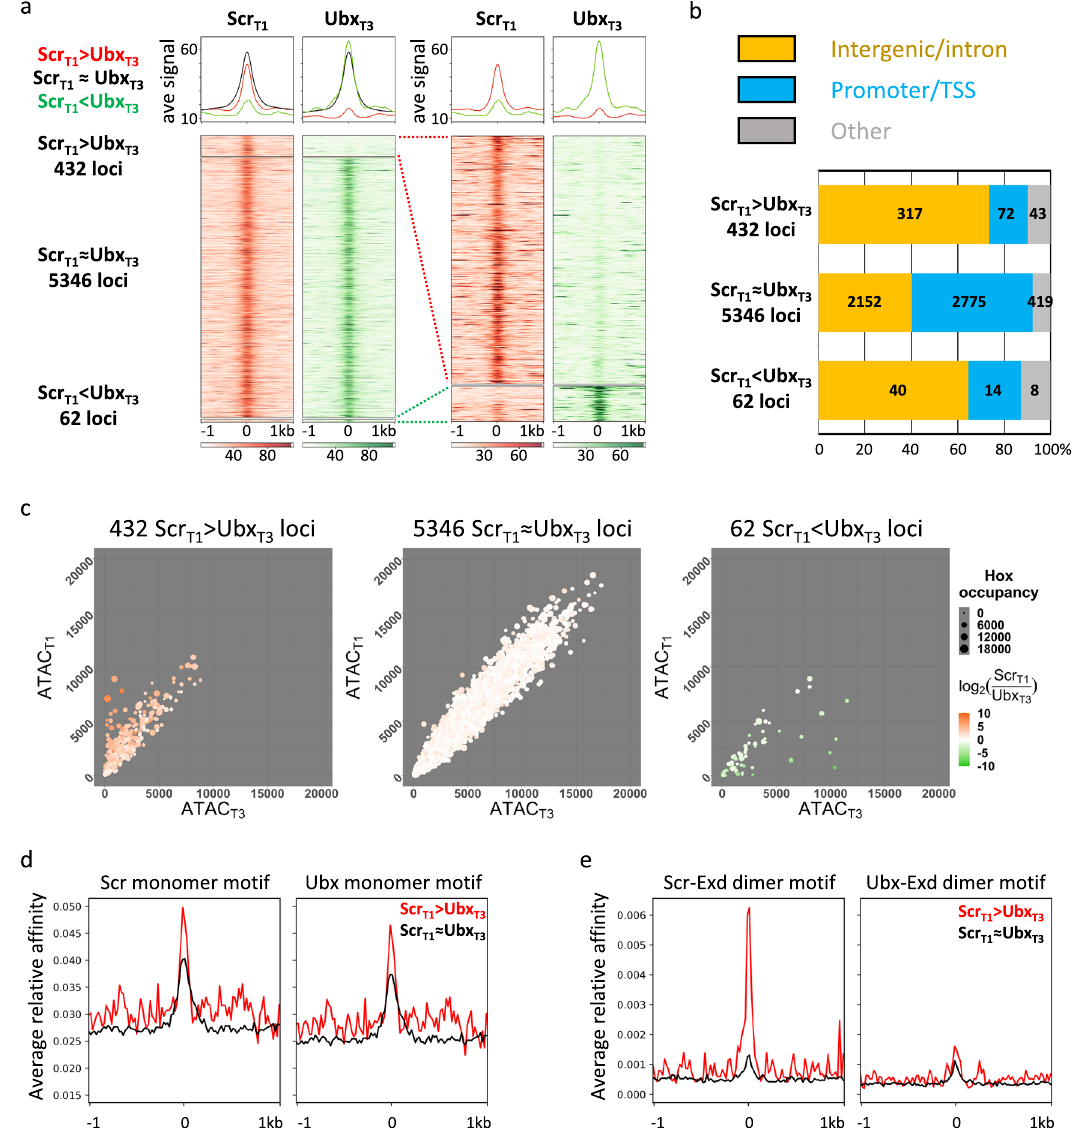
Fig. 2 Genome-wide comparison between Scr T1 and Ubx T3 DNA-binding pro fi les. a Left: heatmaps and histograms of Scr T1 > Ubx T3 , Scr T1 ≈ Ubx T3 and Scr T1 < Ubx T3 loci plotted for Scr T1 and Ubx T3 ChIPs signals. Right: blow-up of the 432 Scr T1 > Ubx T3 and 62 Scr T1 < Ubx T3 loci. Loci in each of the three classes are sorted by the FDR values generated by DiffBind in ascending order (see “ Methods ” for details). The loci are aligned at the peak center, with + / − 1 kb shown. In all heatmaps in this and other panels, the color intensity scores are arbitrary values indicating relative TF occupancy at the target locus. b Bar graph showing the genome region classi fi cation of Scr T1 > Ubx T3 , Scr T1 ≈ Ubx T3 and Scr T1 < Ubx T3 loci. c Scatter plots comparing T1 and T3 chromatin accessibility in Scr T1 > Ubx T3 (left), Scr T1 ≈ Ubx T3 (middle) and Scr T1 < Ubx T3 (right) loci. The size of a dot represents the average of Scr T1 and Ubx T3 ChIP signals at that locus, and the color indicates the log2 ratio between Scr T1 and Ubx T3 ChIP-seq signals. d , e Histograms showing relative af fi nity scores using NRLB models for Scr and Ubx monomers ( d ), and Scr-Exd and Ubx-Exd heterodimers ( e ) in Scr relative to the peak